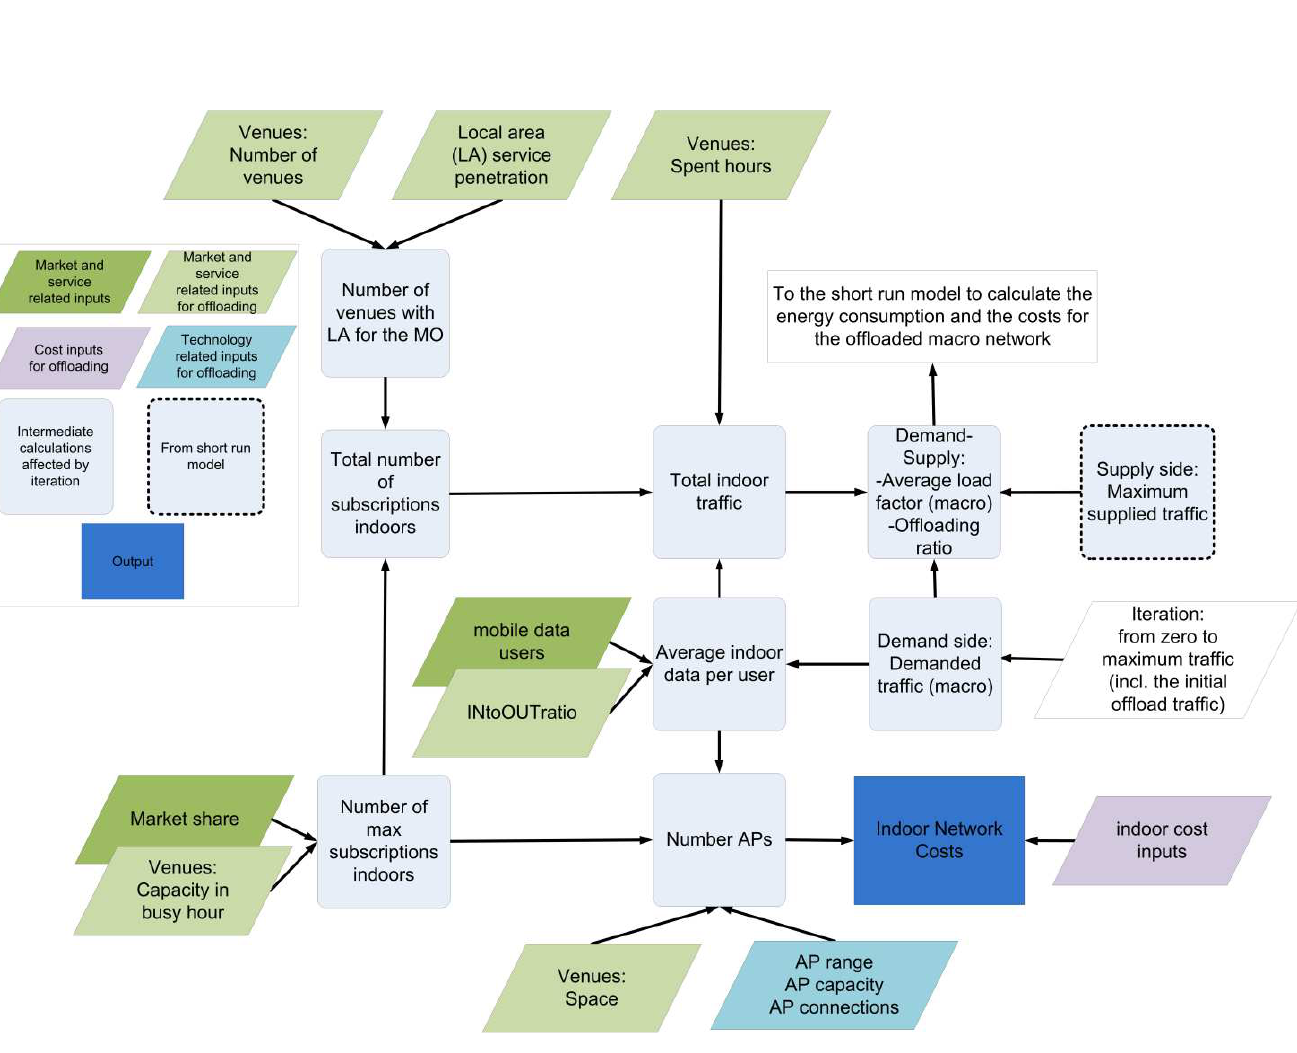
Figure 1 . Wide-to-local area offloading